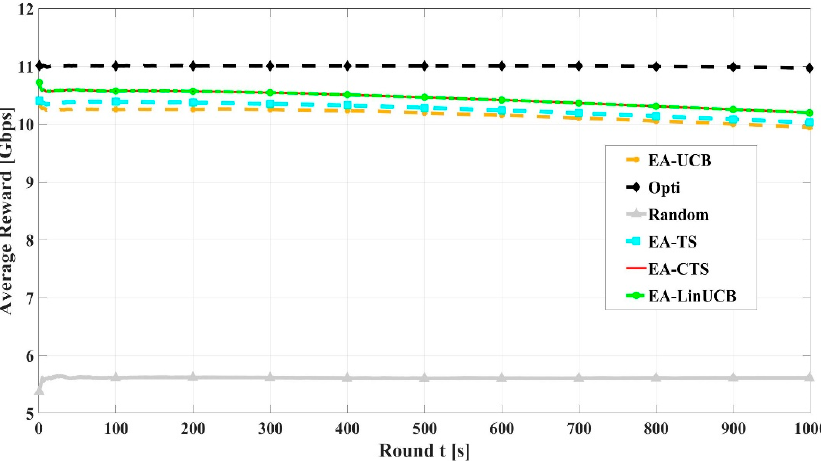
Figure 10. Convergence rate of energy aware algorithms using 60 devices.